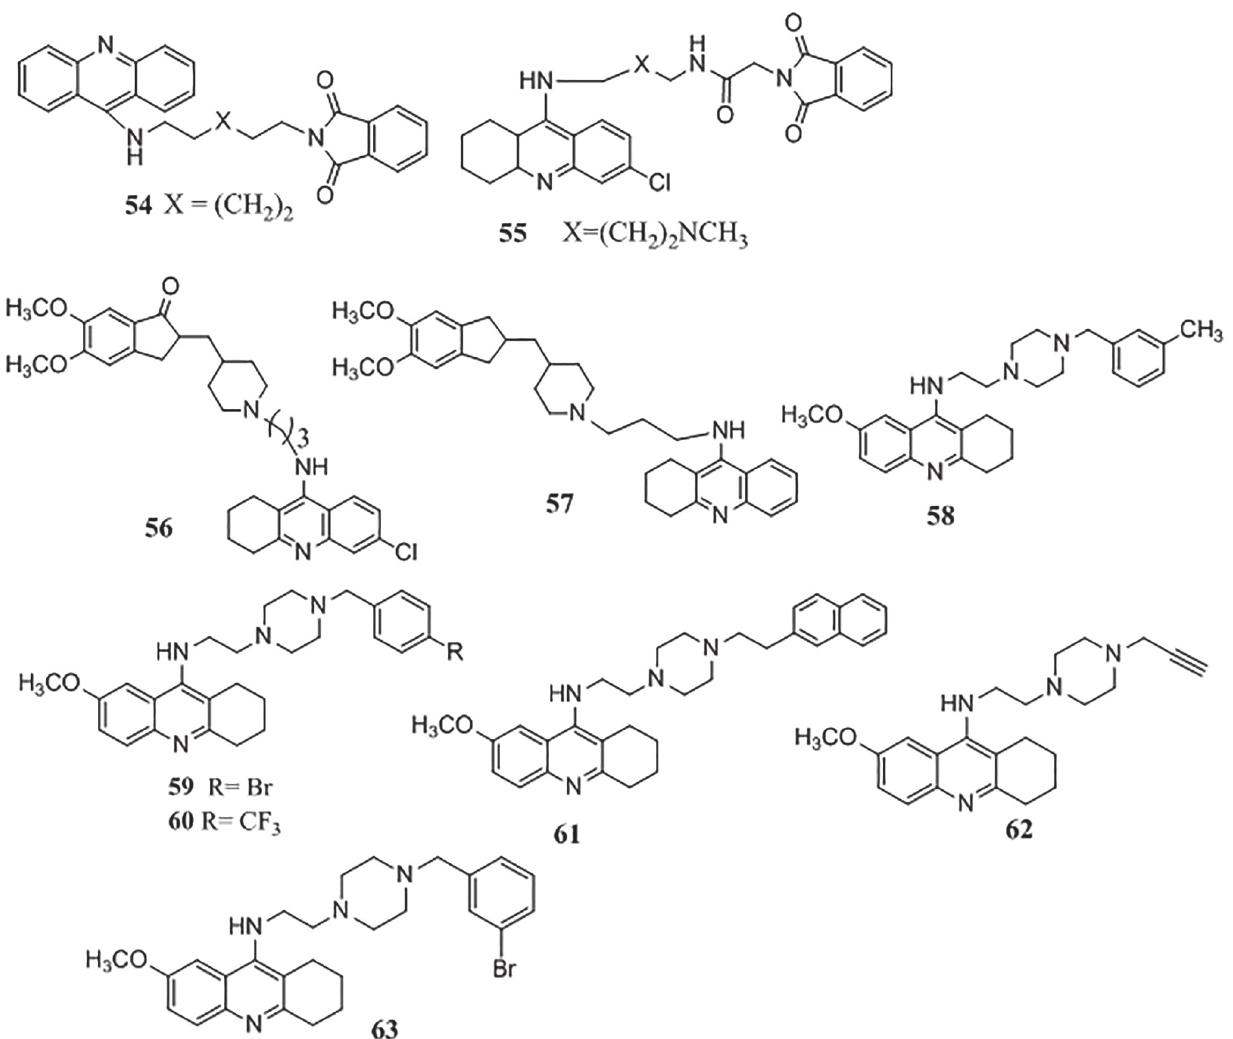
FIGURE 8 - Hybrid molecules comprising donepezil and tacrine